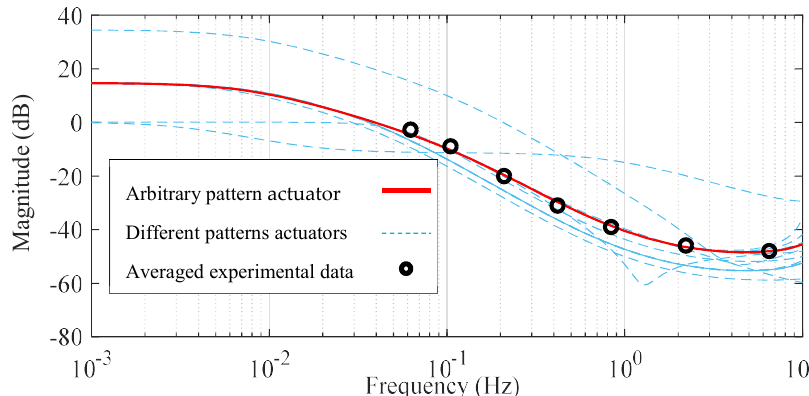
Figure 7. Frequency response system identification of different 3D-printed actuators in response to the 5V input signal.